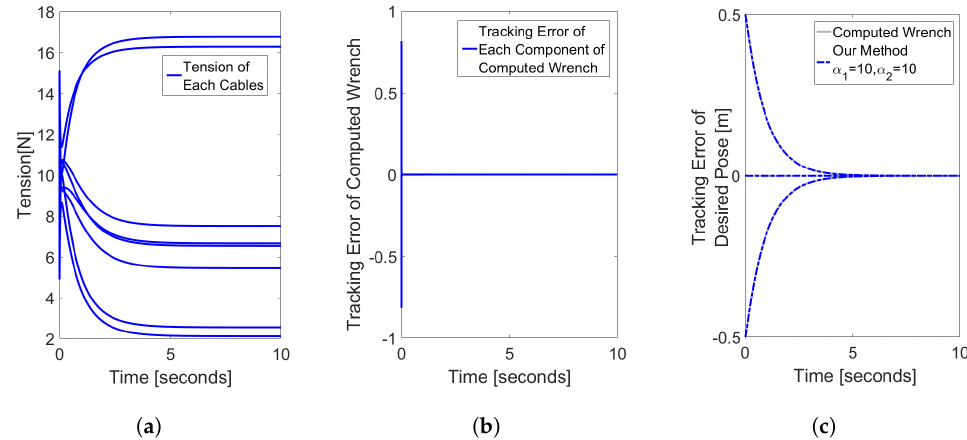
Figure 4. Results of Simulation 1. Parameters and desired pose are selected as α = 10, K d = 10, D d = 10, K i = 0.1, q d = [ 0.6, − 0.6,0.6,0,0,0 ] T . ( a ) Tension distribution in Simulation 1. ( b ) Tracking error of computed wrench. ( c ) Tracking error of desired pose.